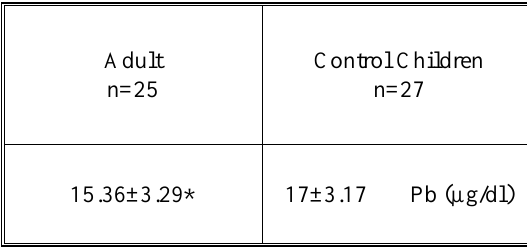
Data are presented as (mean±SD).